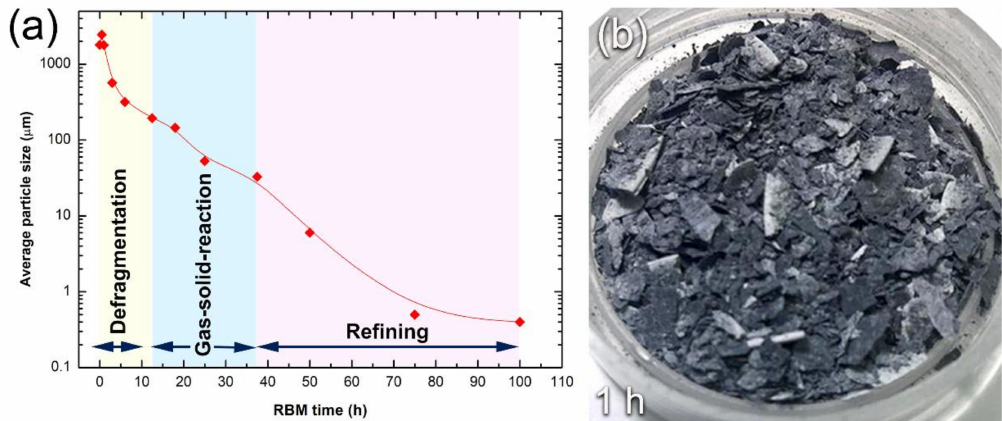
Figure 8. ( a ) Particle size distribution of as-CR Mg strips during the di ff erent stages of milling named; defragmentation; gas-solid reaction; and refining stages, and ( b ) an optical image of the sample obtained after 0.5 h RBM.